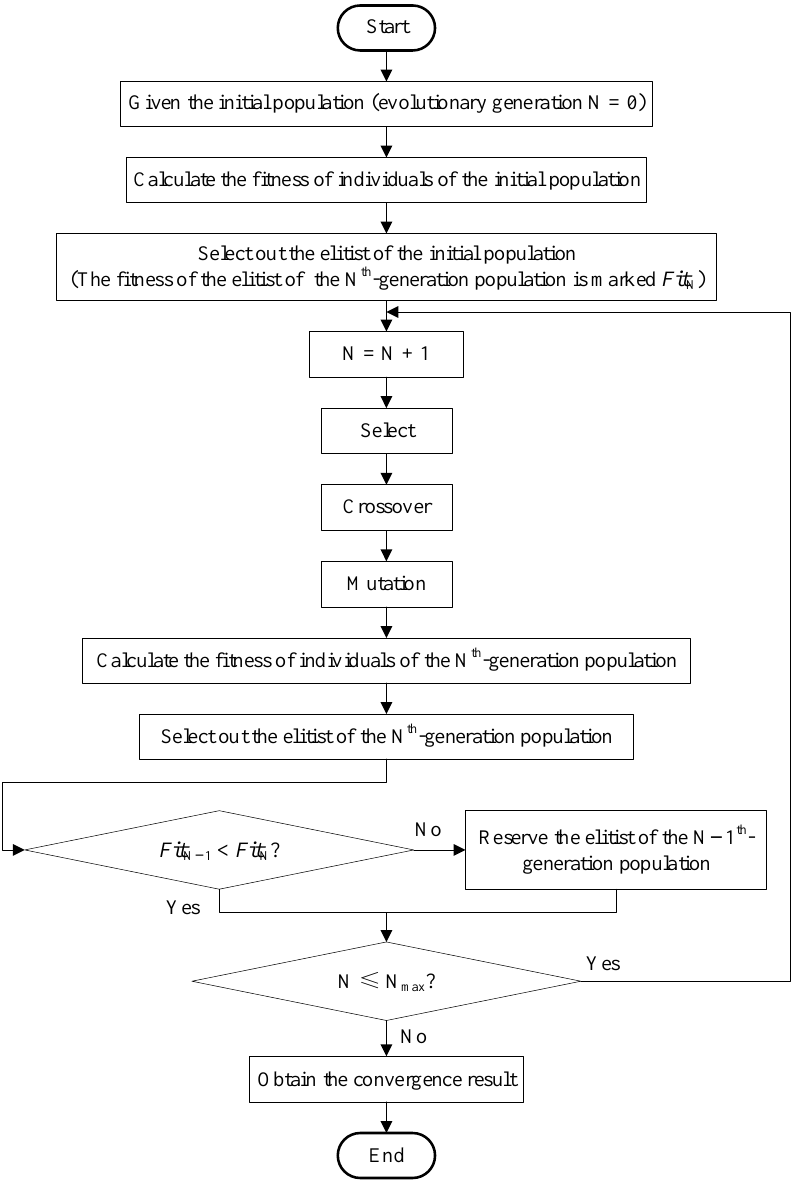
Figure 2. Overview of the genetic algorithm with elitist preservation strategy.